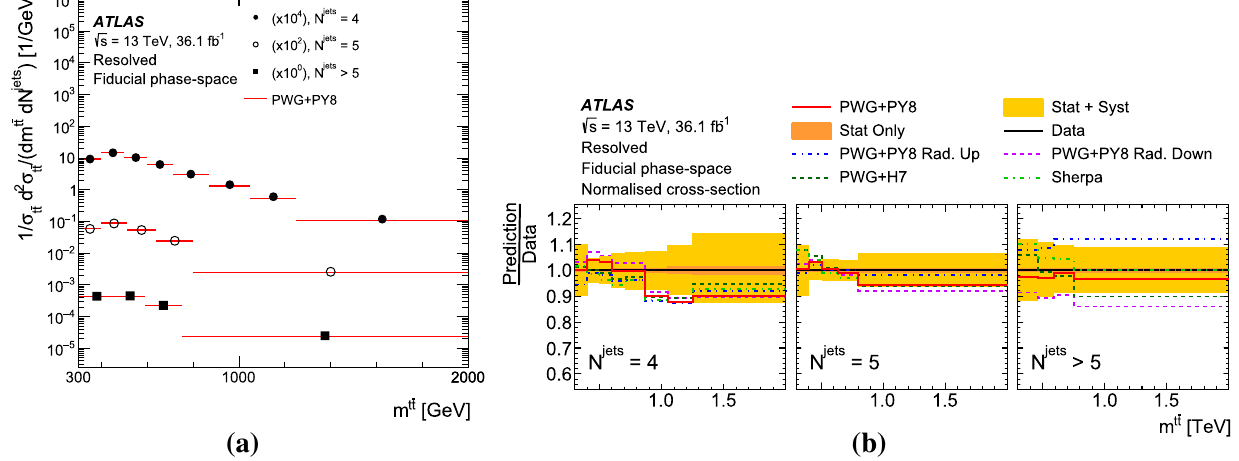
Fig. 30 a Particle-levelnormaliseddifferentialcross-sectionasafunc- tion of m t ¯ t in bins of the jet multiplicity in the resolved topology com- pared with the prediction obtained with the Powheg + Pythia8 MC